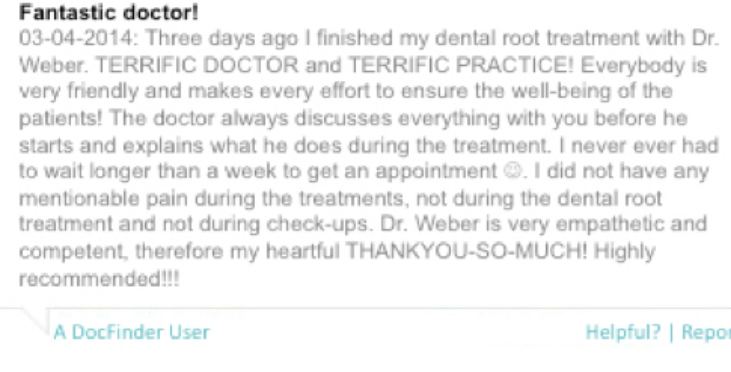
Figure 3. Manipulated rating card for the low-number/factual review